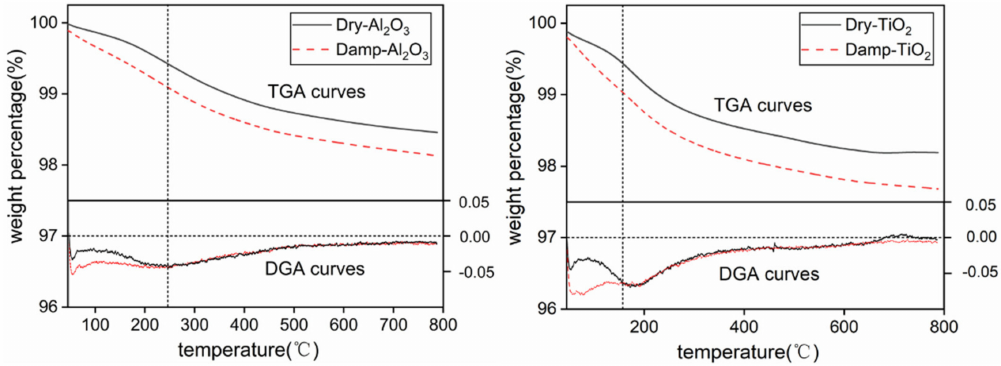
Figure 4. TGA and DGA curves of